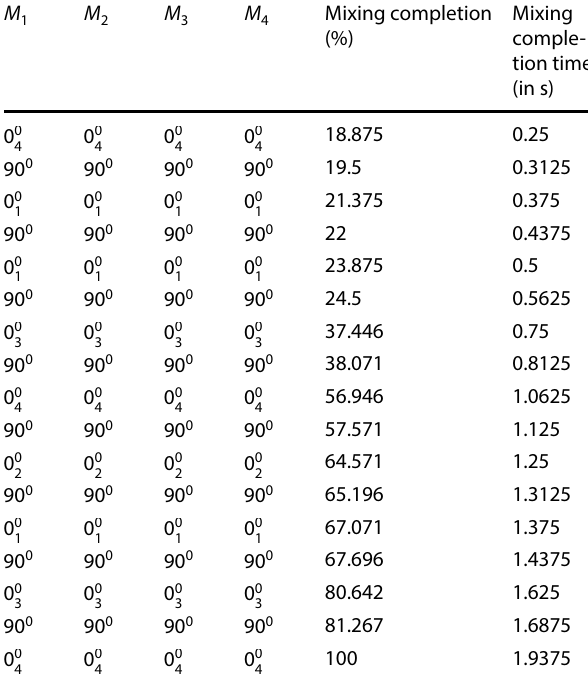
computed in Table 5. Shift patterns with escaped time- steps(t) for MEDA are given in Equation No. 9 and 10.